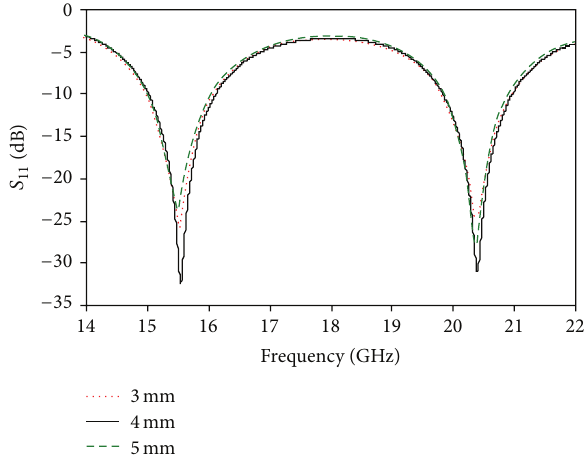
Figure 4: Simulated return loss for different values of 𝑊 1 .